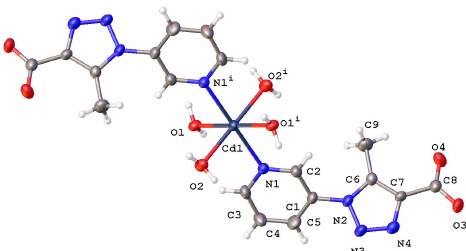
Figure 3. View of local coordination geometry at the Cd(II) center in compound 1 (30% ellipsoid probability). Symmetry code (i) is 1 − x,1/2 + y,3/2 − z.